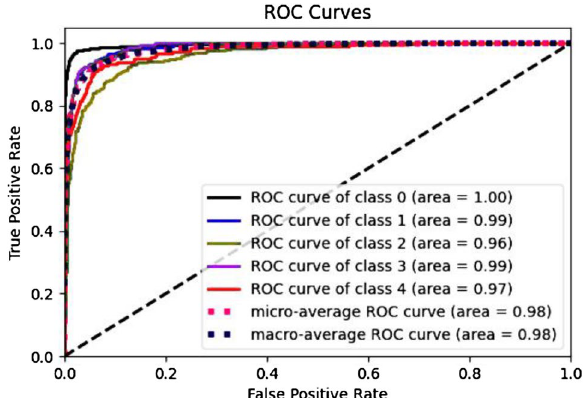
Figure 7. Receiver Operating Characteristic (ROC) curves for each class of DR lesions.